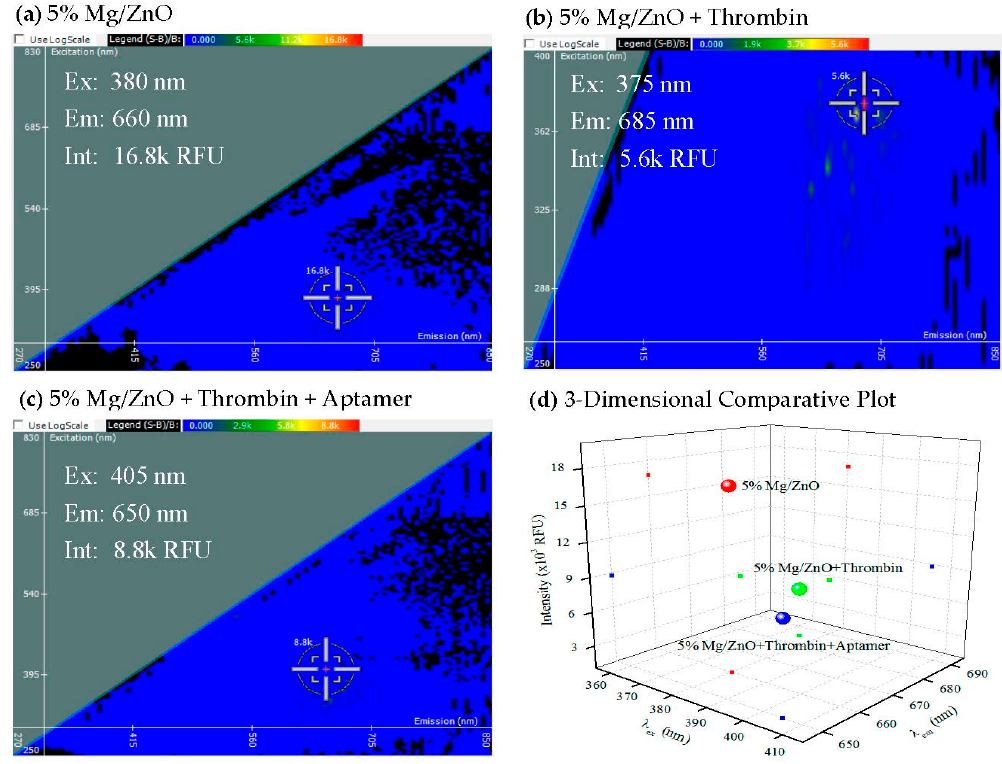
Figure 4. 2-D FDS of ( a ) 5% magnesium with 95% zinc oxide; ( b ) thrombin bound to 5% Mg/ZnO; and ( c ) thrombin and thrombin aptamer bound to 5% Mg/ZnO; ( d ) Three-dimensional comparative plot of the three 5% Mg/ZnO thrombin interactions.